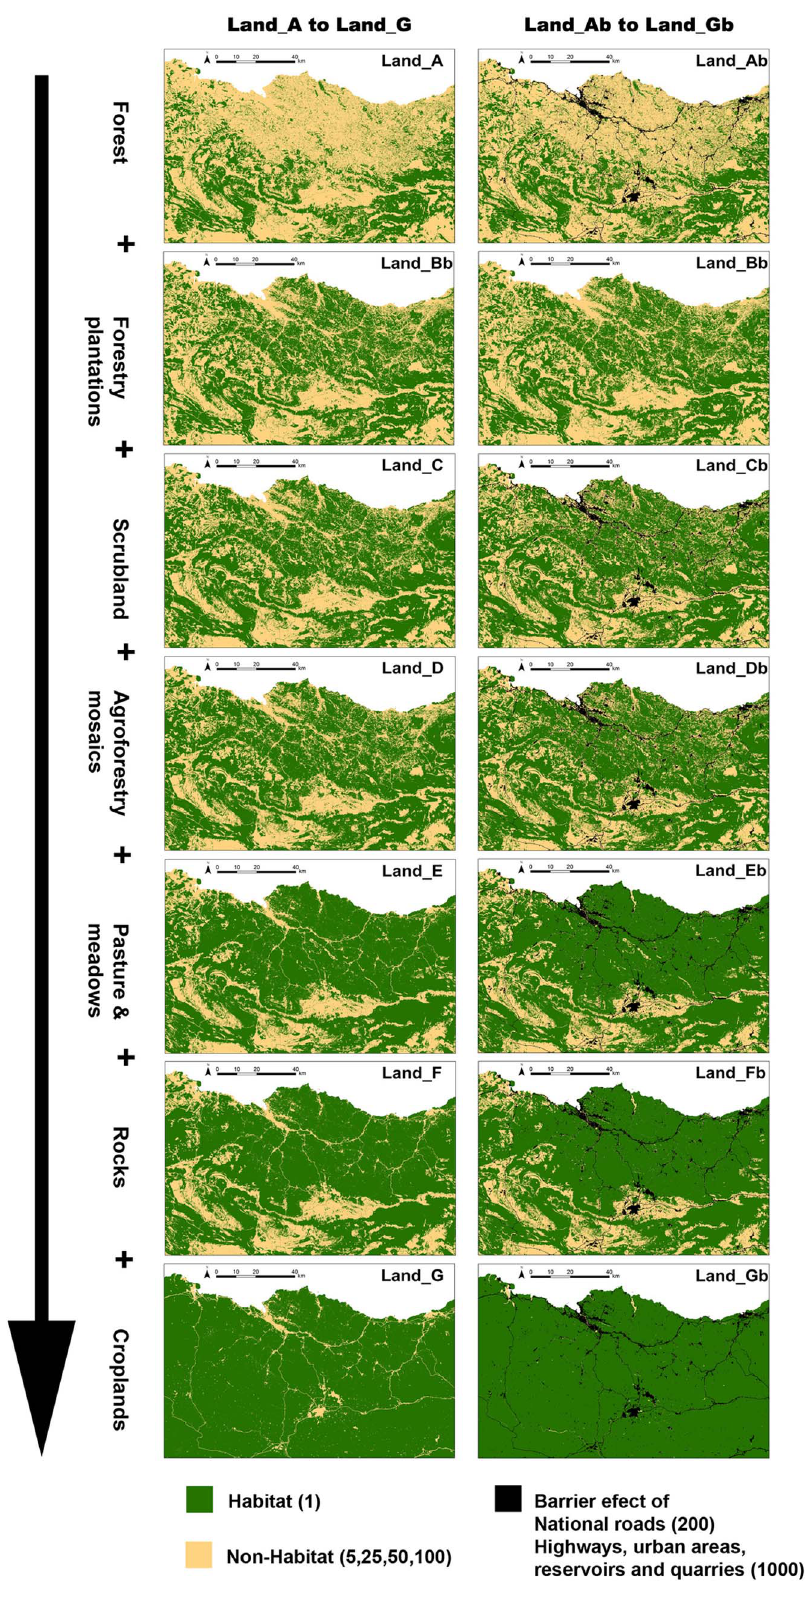
Figure 2. Binary landscape resistance maps on a gradient from greater to lesser preference of the focal species in relation to forest environment. Binary landscape resistance maps, on a gradient from greater to lesser preference of the focal species in relation to forest environment (Land_A to Land_G). Green-coloured cells represent ‘‘Habitat’’ (resistance value 1) and yellow-coloured cells ‘‘Non-Habitat’’ (resistance